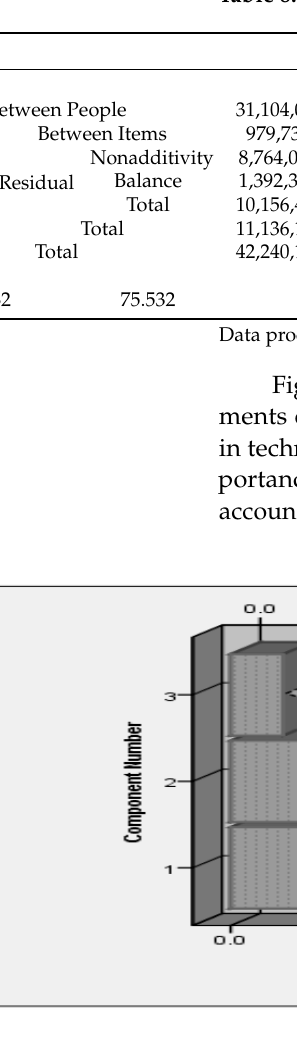
Table 8. Results of the second sub-factor (F1.2) of sustainable profit through reliability analysis.